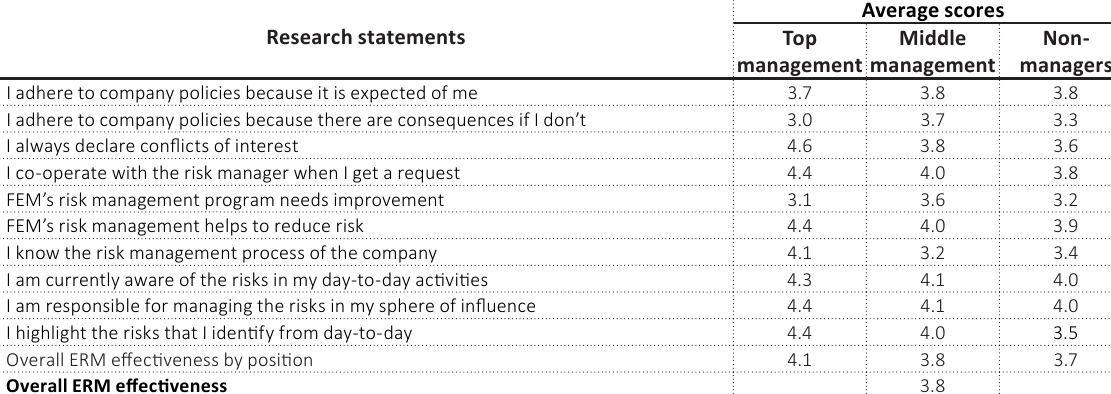
Table 4. Perceptions of ERM